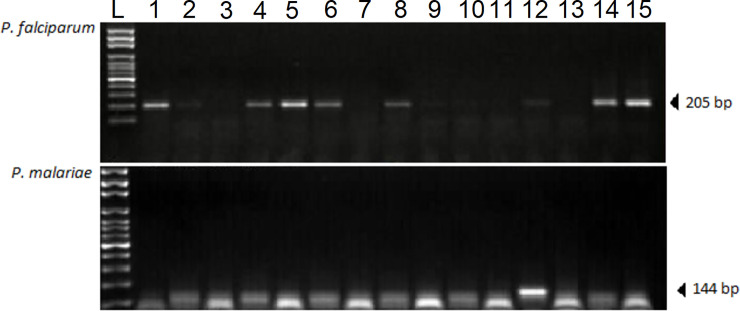
Agarose gel electrophoresis showing nPCR products under UV light.The top panel shows representative results of the P. falciparum-specific nested PCR. Lanes 1, 4, 5, 6, 8, 12, 14, and 15 contain the positive 205 bp PCR products expected. The bottom panel shows representative results of the P. malariae-specific nested PCR. Lane 12 contains the positive 144 bp PCR product expected. Smaller bands are likely due to low DNA concentration in those samples. L represents the molecular ladder.